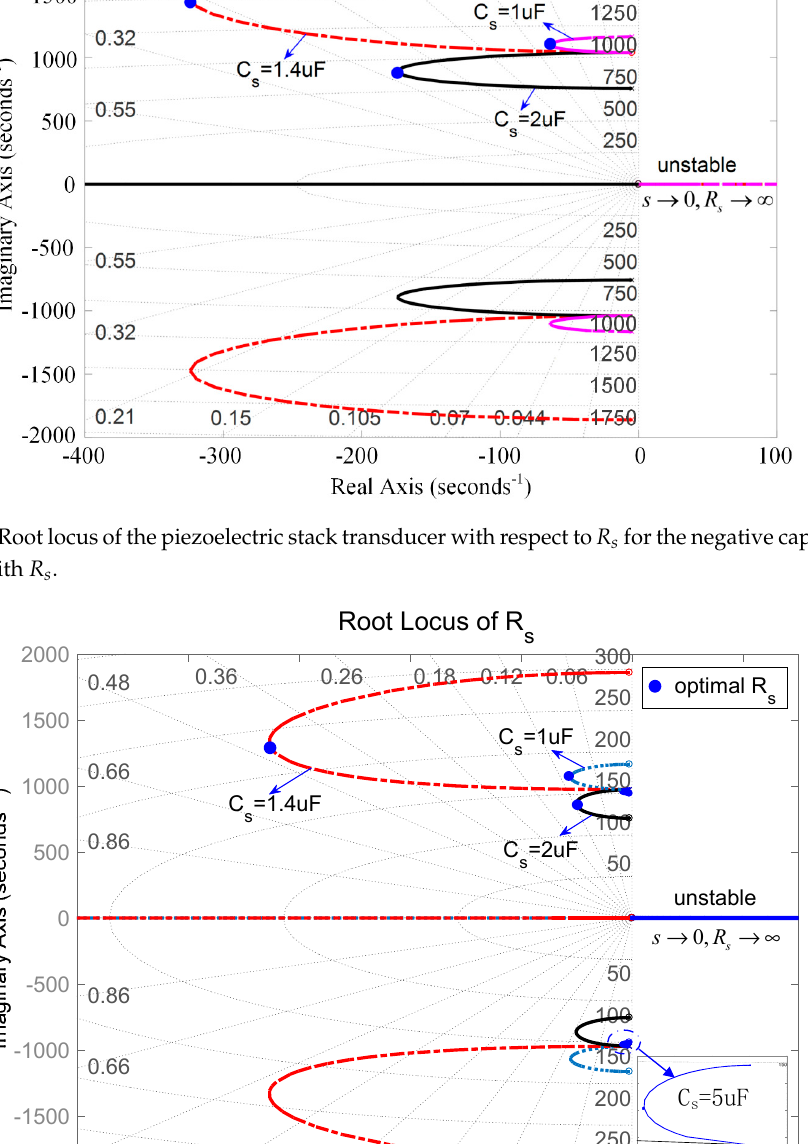
Figure 13. Root locus of the piezoelectric stack transducer with respect to R s for the negative capacitance in parallel with R s .